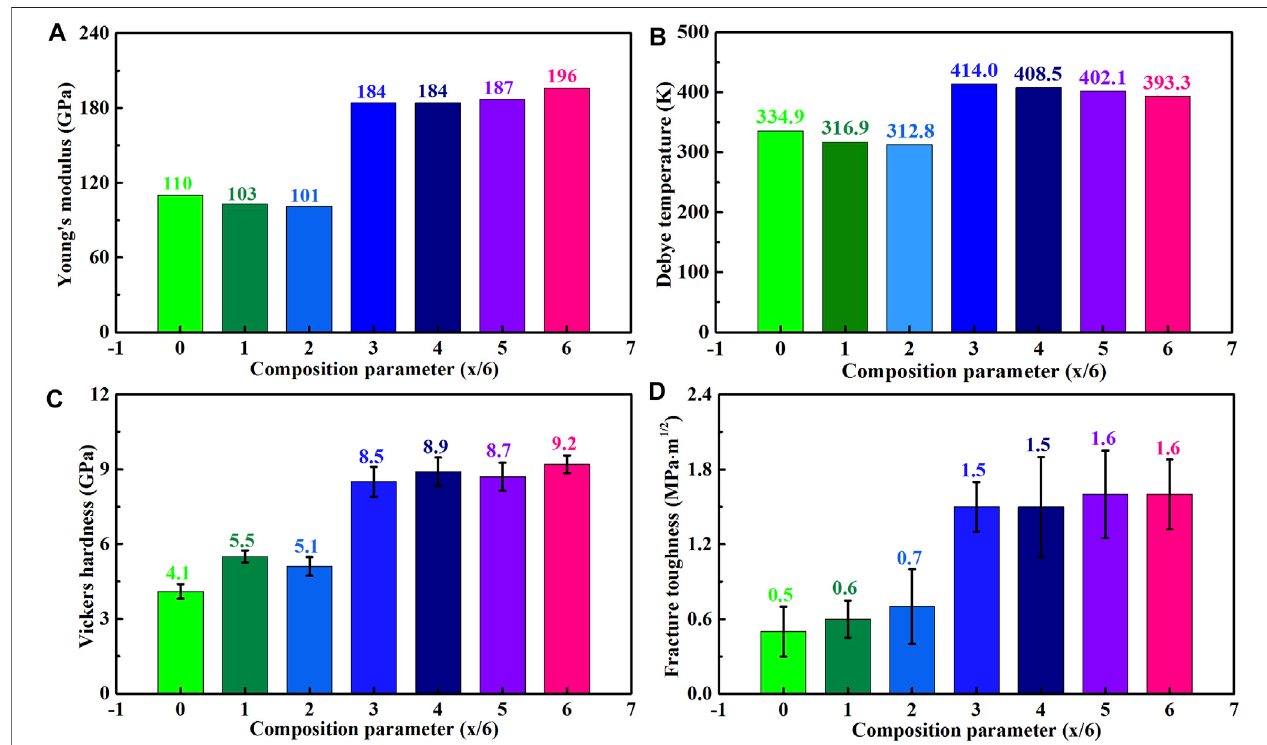
FIGURE 4 | Mechanical properties of (La 1-x Ho x ) 3 NbO 7 ( x (cid:2) 0/6, 1/6, 2/6, 3/6, 4/6, 5/6, and 6/6) ceramics: (A) Young ’ s modulus, (B) Debye temperature, (C) Vickers hardness, and (D) fracture toughness.